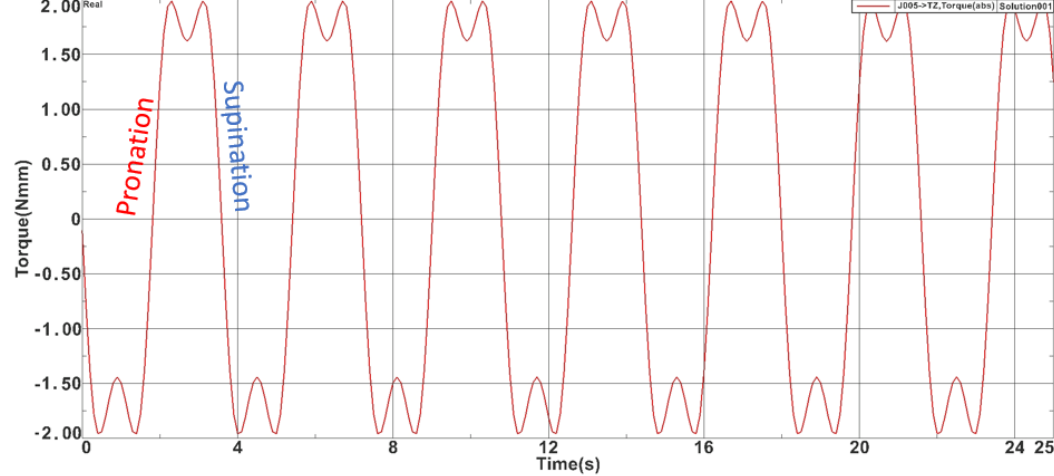
Figure 7. Torques recorded during the pronation-supination module simulation.